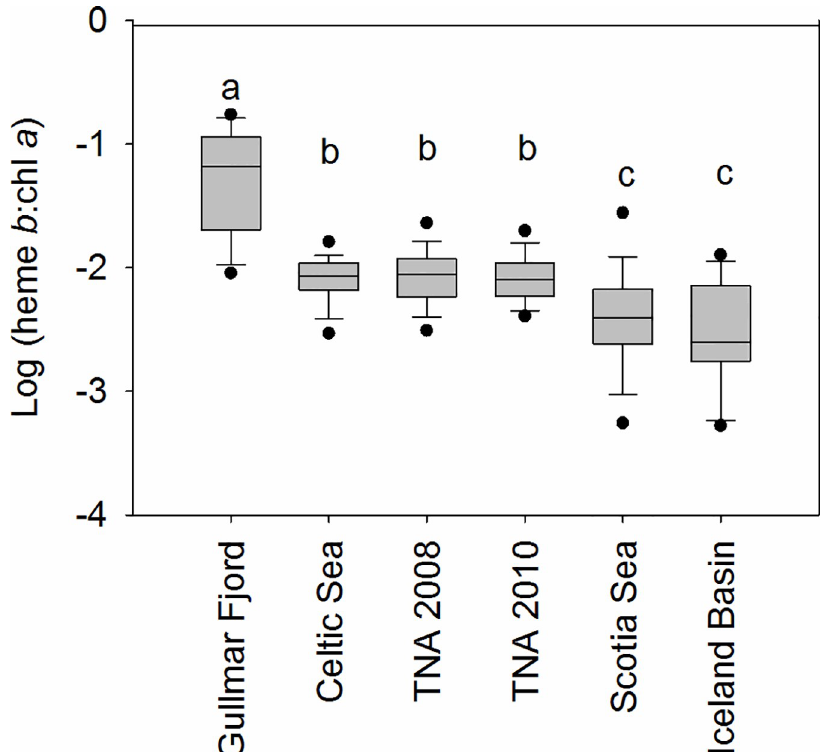
Fig 6. Box and whisker plot for log(heme b : chlorophyll a ) values reported. From Gullmar Fjord (this study, n = 19), Celtic Sea (n = 27), (sub)-tropical North Atlantic in 2010 (n = 377; [6]) tropical North Atlantic in 2008; (n = 268), Scotia Sea (n = 34) and the IcelandBasin (n = 83, [12]). Black circles indicatethe 5 th /95 th percentile for log(heme b : chlorophyll a ). Letters denotesignificantly different groups (one way non parametric ANOVA, p <